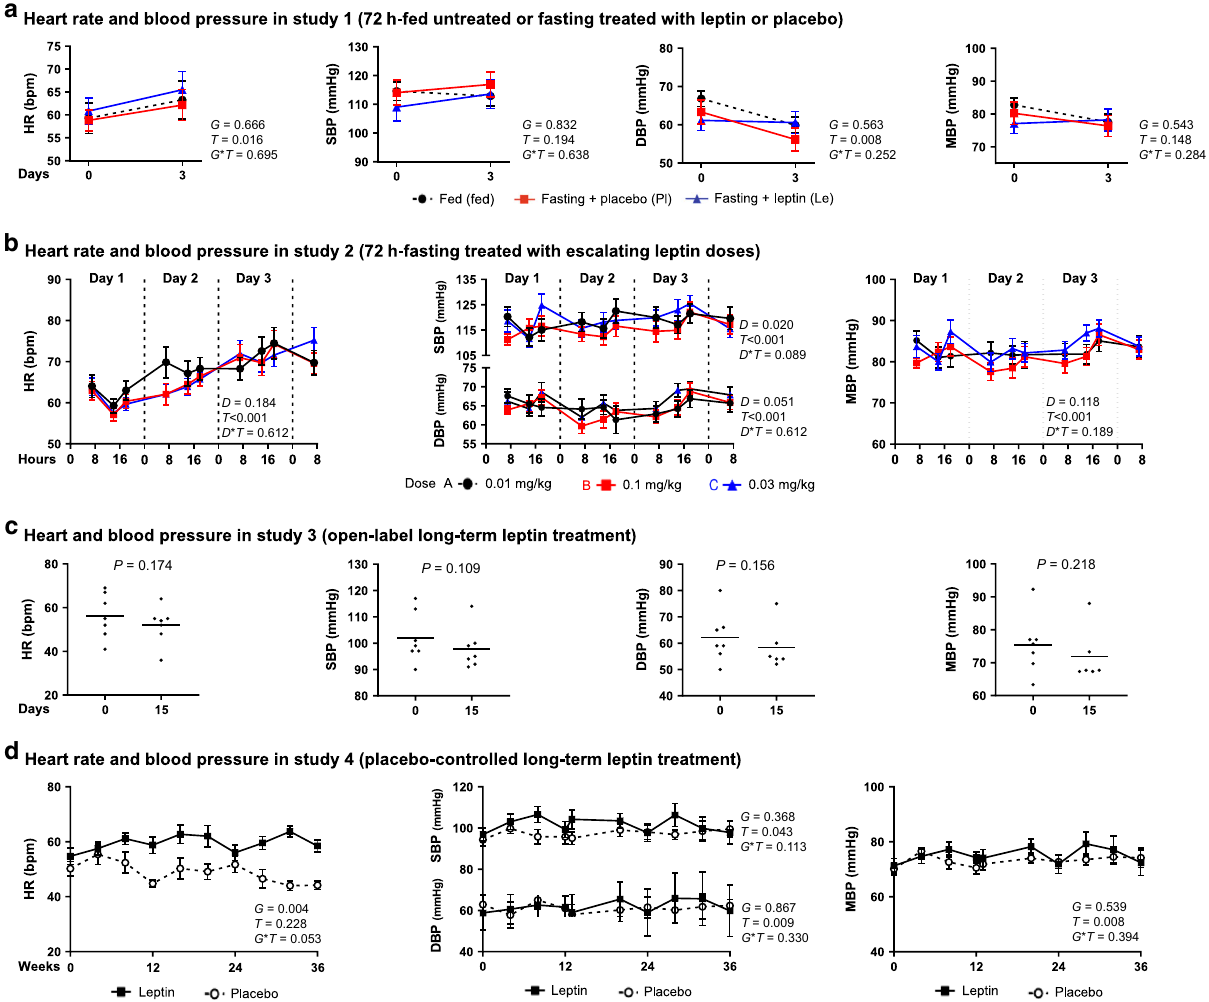
Fig. 4 Leptin effects on heart rate and blood pressure. a Seventy-two hours fed state or fasting + leptin or fasting + placebo (study 1, n = 13). P values of G (group: fed or fasting + placebo or fasting + leptin), T (time: days of study), and G * T interaction of mixed models adjusted for baseline are reported. b Seventy-two hours fasting treated with escalating leptin doses (study 2, n = 15). P values of D (dose: 0.01 or 0.1 or 0.3 mg/kg/d), T (time: hours of fasting), and D * T interaction of mixed models adjusted for baseline are reported. c Open-label long-term leptin treatment in mildly hypoleptinemic women (study 3, n = 7). P value ( P ) of paired t test is reported. d Placebo-controlled long-term leptin treatment in mildly hypoleptinemic women (study 4, n = 19 (leptin = 10; placebo = 9)). P values of G (group: placebo or leptin), T (time: weeks of study), and G * T interaction of mixed models adjusted for baseline are reported. No post hoc Bonnferroni test was performed since G * T > 0.05 (studies 1 and 4) and D * T > 0.05 (study 2). All P values are two-sided. Data